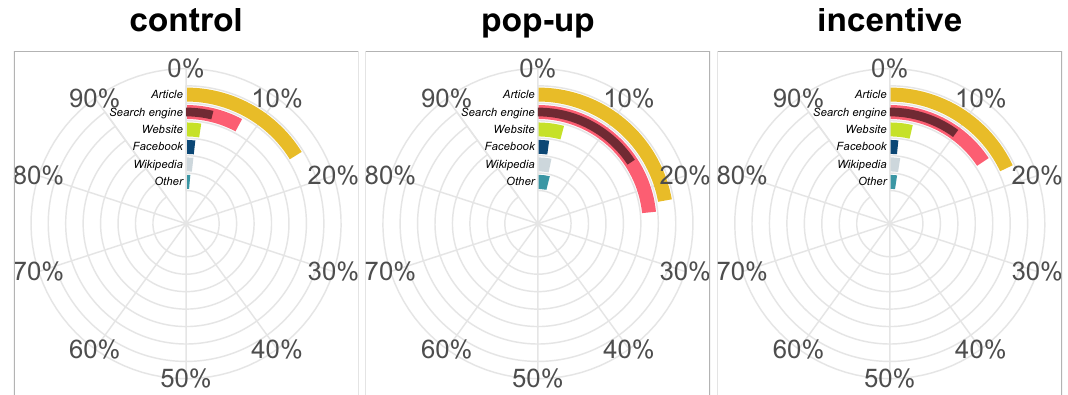
Figure 3. Race chart of self-report external search behaviour. Bars indicate the proportion of participants in each experimental condition reporting to have searched in either category of websites. Lateral reading is identified with the proportion of participants searching information on a search engine (light red), whereas click restraint is the subset of these participants who reported not stopping at the first algorithmically-ranked results of the search (dark